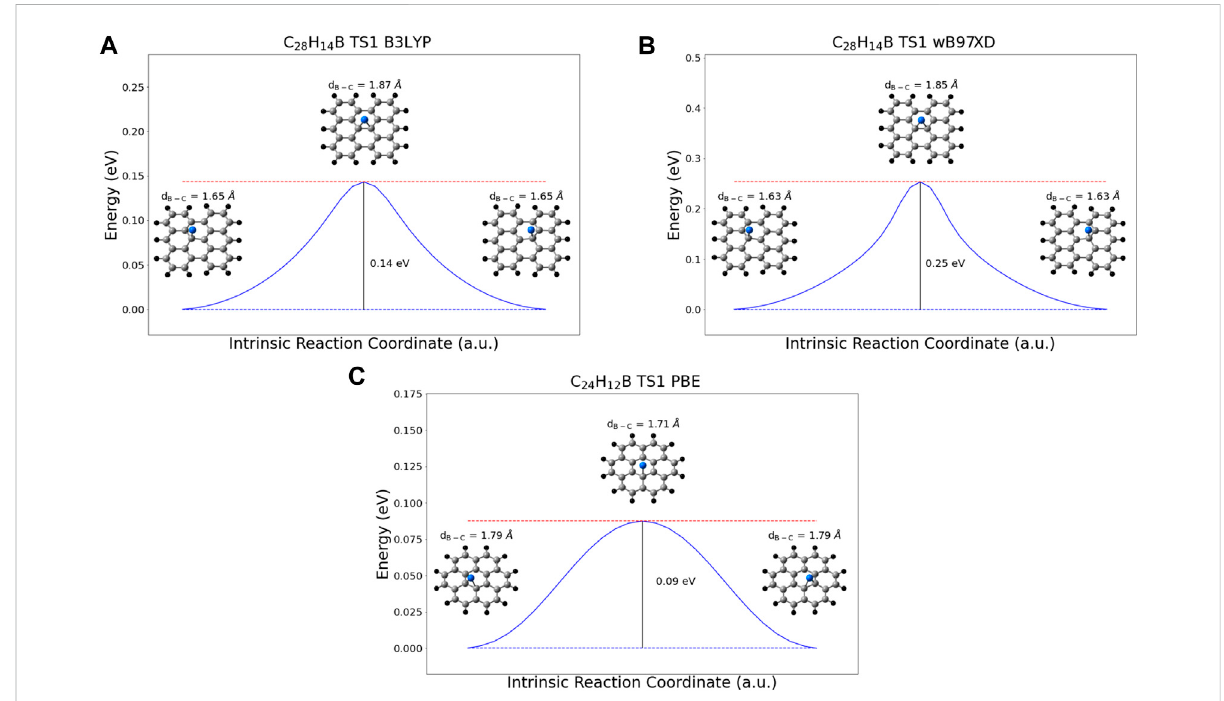
FIGURE 5 IRC potential energy scans for the migration of the boron adatom between adjacent binding sites, using the (A) B3LYP functional (B) wB97XD functional, and (C) PBE functional. Scans performed in (A) and (B) used a bisanthene molecule as a model for graphene, the scan performed in (C) usedcoronene.Theenergiesdepictedareinreferencetotheenergyofthefullyboundstate,andnozero-pointenergycorrectionshavebeenmade. Carbon = Grey, Hydrogen = Black, and Boron =